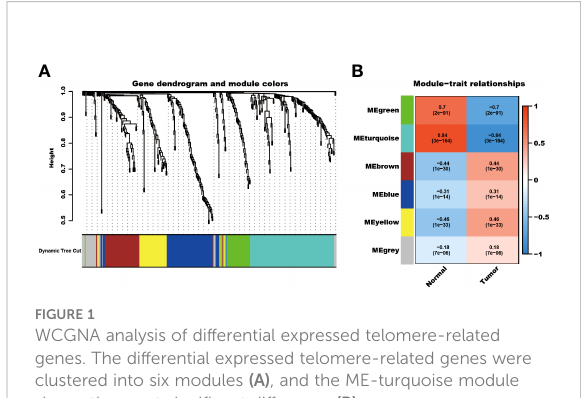
FIGURE 1 WCGNA analysis of differential expressed telomere-related genes. The differential expressed telomere-related genes were clustered into six modules (A) , and the ME-turquoise module shows the most signi fi cant difference (B) .